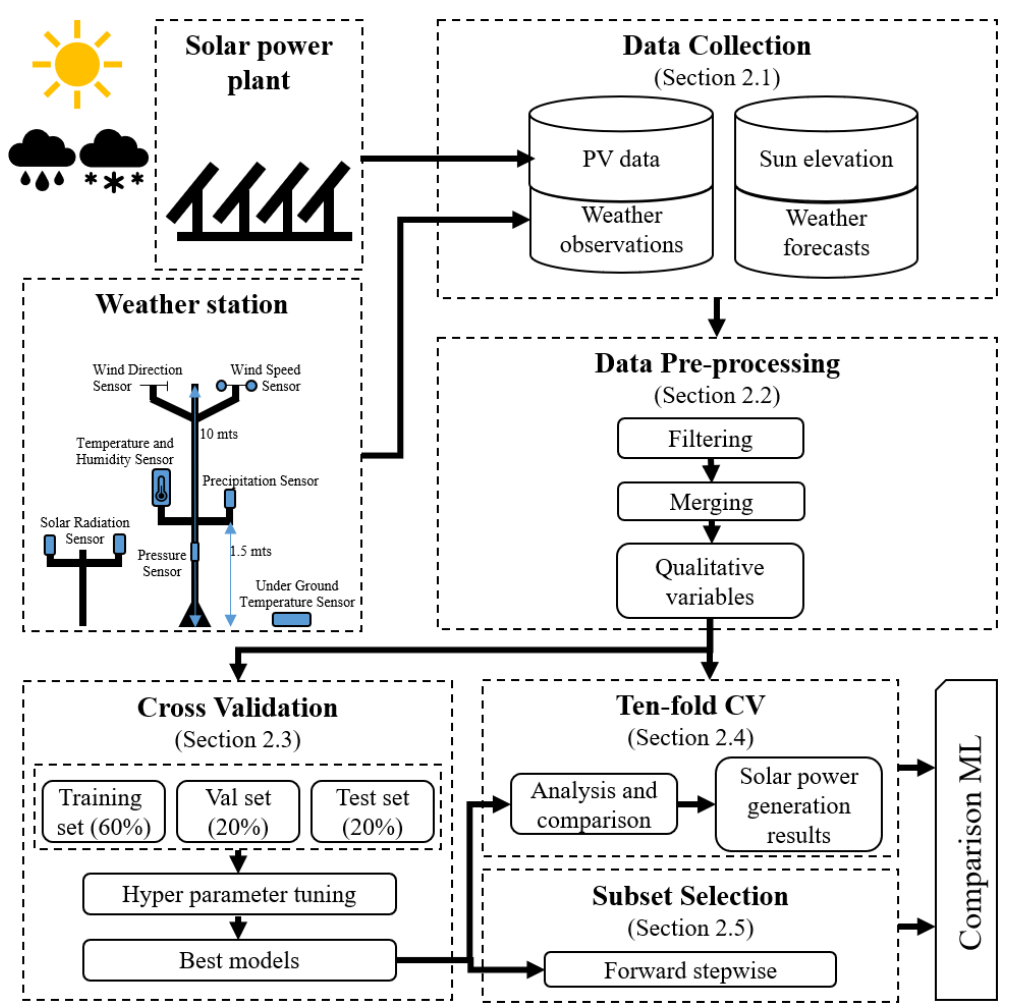
Figure 1. Proposed framework for the analysis and comparison of the machine learning techniques for photovoltaic prediction.